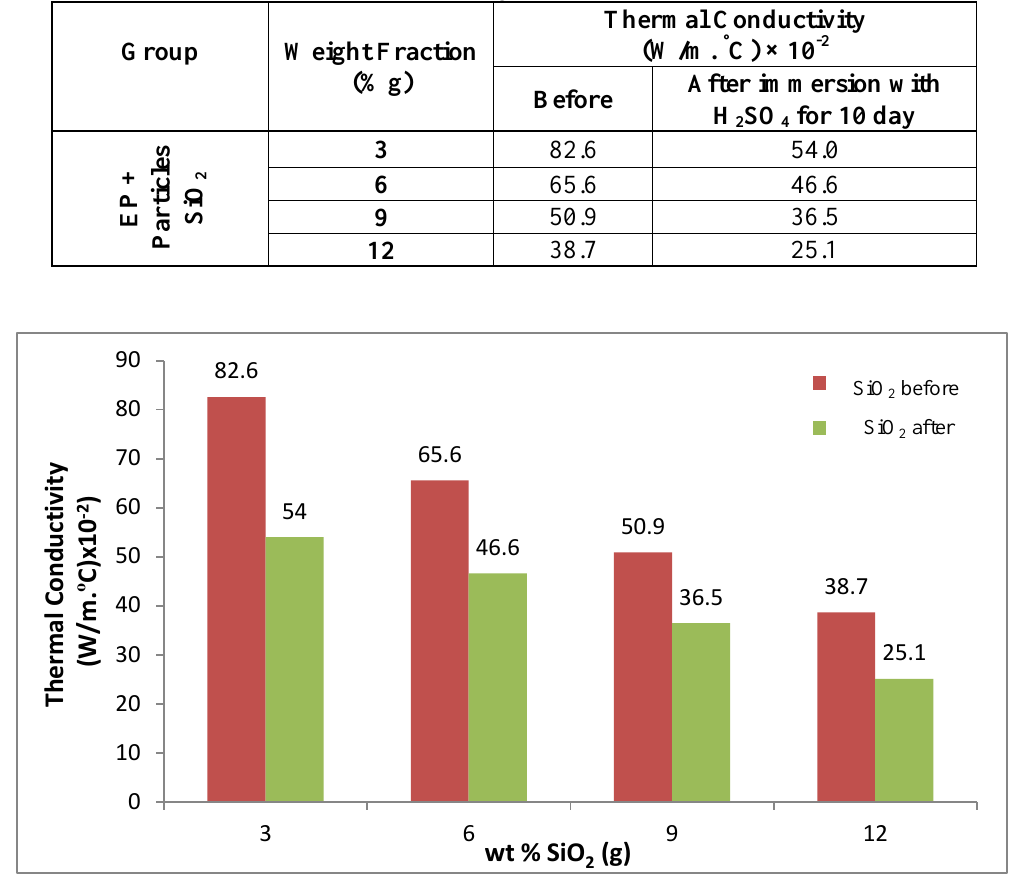
Table 2: Scientific results of the thermal conductivity of SiO immersion with H